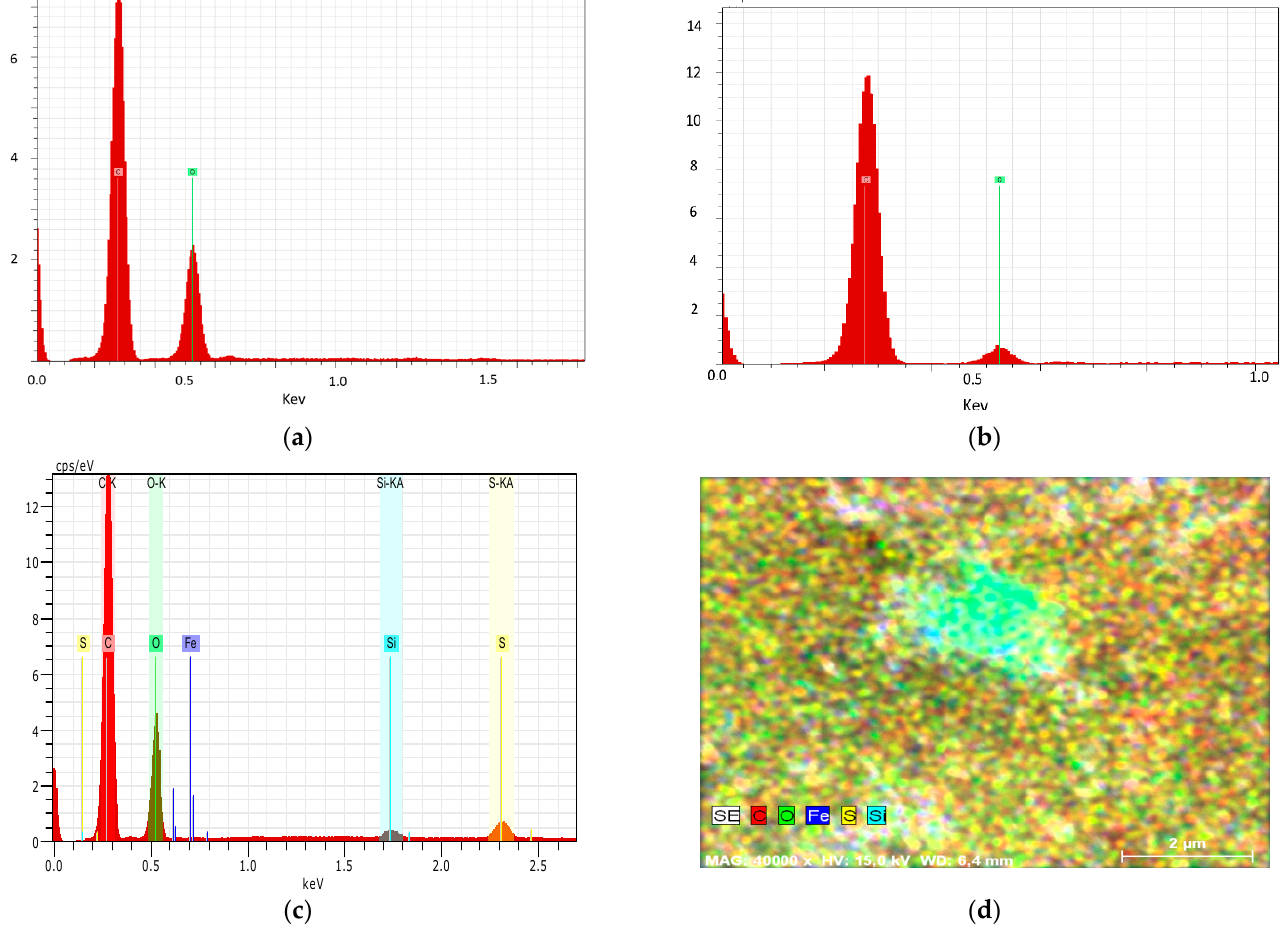
Figure 4. EDX spectra of ( a ) GO, ( b ) RGO, and ( c , d ) RGO-IONs nanocomposite. Raman spectra are shown in Figure 5a,b for graphene oxide before and after reduction, where the reduced graphene oxide phase is confirmed by the D and G bands located at 1330 cm − 1 and 1590 cm − 1 , respectively.